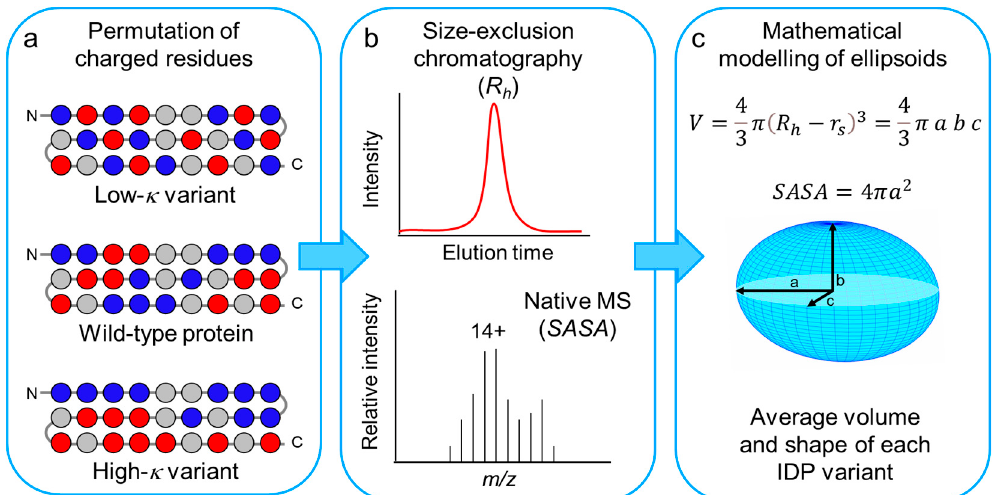
Figure 1. Scheme of the experimental plan used in this work. ( a ) Scheme of the primary structures of a protein set, derived from a generic wild-type IDP by distributing more evenly the oppositely charged residues (low- κ variant) or by clustering them in two blocks at the N- and C-moieties (high- κ variant). Only charged residues were permutated, preserving the original location in the sequence of non-charged residues (see also Figure S1). Blue and red spheres indicate positively and negatively charged residues, respectively. Gray spheres indicate all the other amino acid residues. ( b ) The conformational ensemble of each model IDP was investigated by size-exclusion chromatography (SEC) and native mass spectrometry (MS), to derive experimental values of R h and SASA . ( c ) R h and SASA values were combined to calculate the volume and depict the average shape from the ensemble of each model IDP.